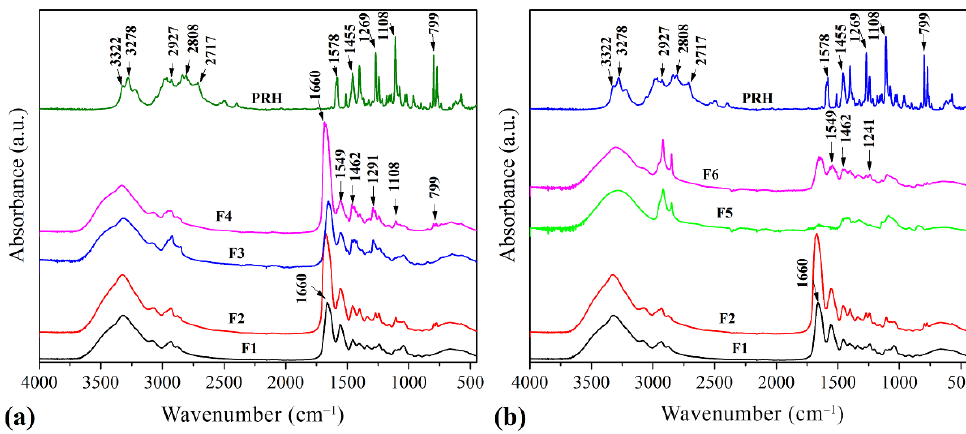
Figure 1. FTIR spectrum of 3D printed films ( a ) F1, F2, F3, F4, and PRH; ( b ) F1, F2, F5, F6, and PRH. The spectrum of the F3 blend is very similar to the spectrum of F1 with emphasized bands at 2929 and 2869 cm − 1 due to the asymmetric and symmetric C–H stretching vibrations, respectively [39]. There is also another prominent peak at 1653 cm − 1 due to C=O stretching